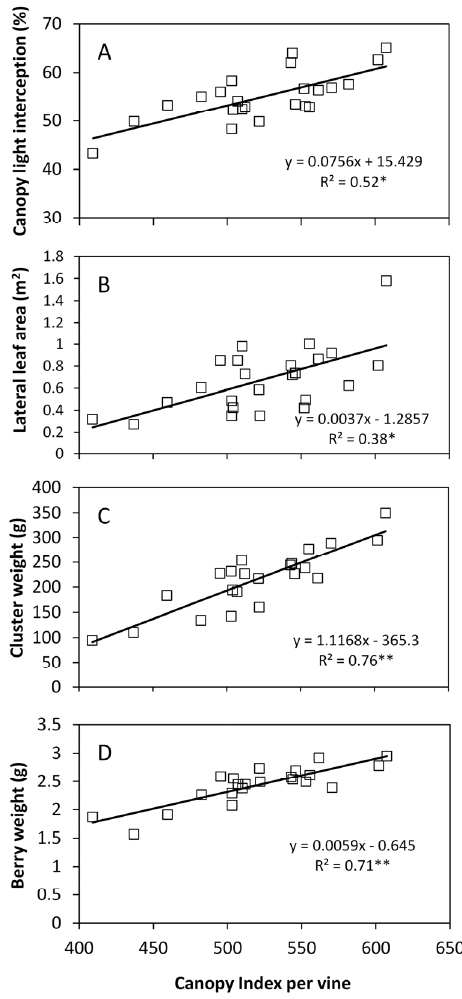
Figure 10. Correlations of Canopy Index vs. canopy light interception ( A ), total lateral leaf area per vine ( B ), cluster weight ( C ) and berry weight ( D ). Equations of linear models are reported inside panels. R 2 is the Coefficient of Determination. Each point corresponds to a single vine ( n = 24). * and ** indicate significant at p ≤ 0.05 and 0.01, respectively.